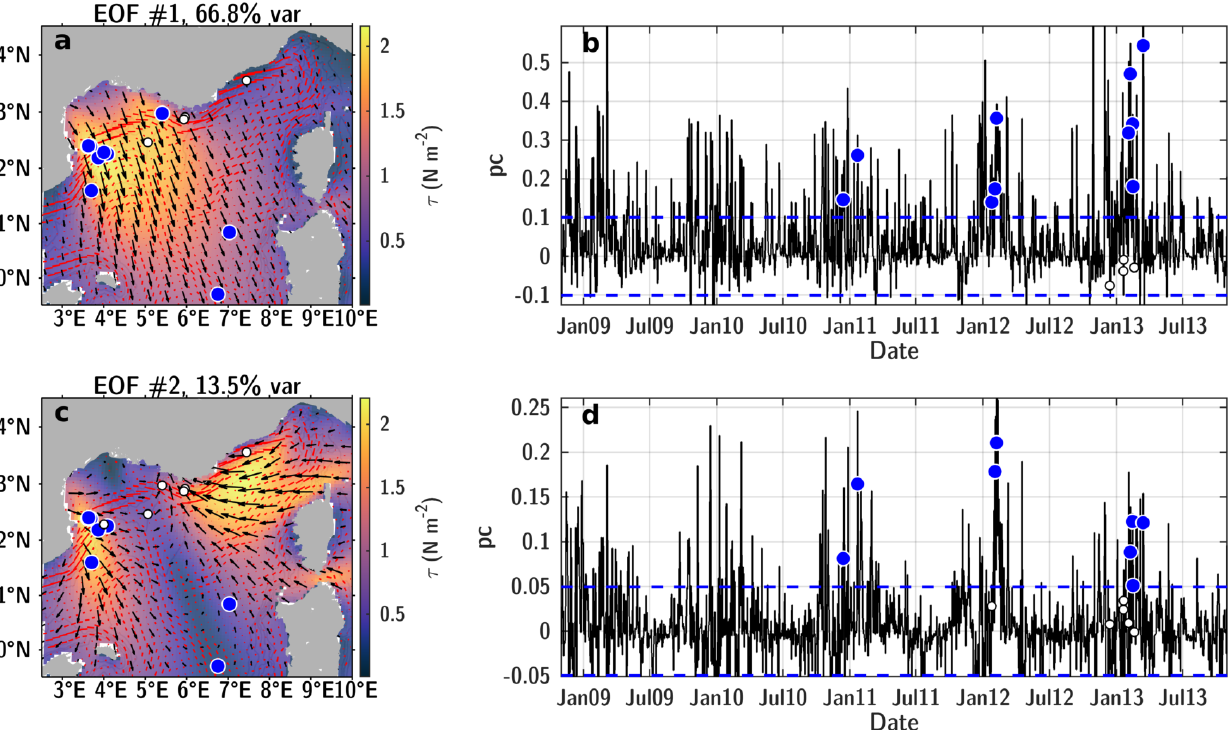
Figure 10. Principal component analysis of daily wind stress from CNRM-ALADIN reanalysis (2009–2013). ( a ) First EOF representing 66.8% of the signal variance. Dots represent the spatial distribution of SI events with blue dots during period when pc exceeds one standard deviation. The red arrows shows the yearly average surface circulation from the model. ( b ) Time series of the eigenvalues for the first EOF. The dashed blue lines are drawn at ± one std. Dots show pc values during SI events (in blue for those exceeding one std). ( c , d ) same as ( a , b ) but for the second EOF (13.5% of the